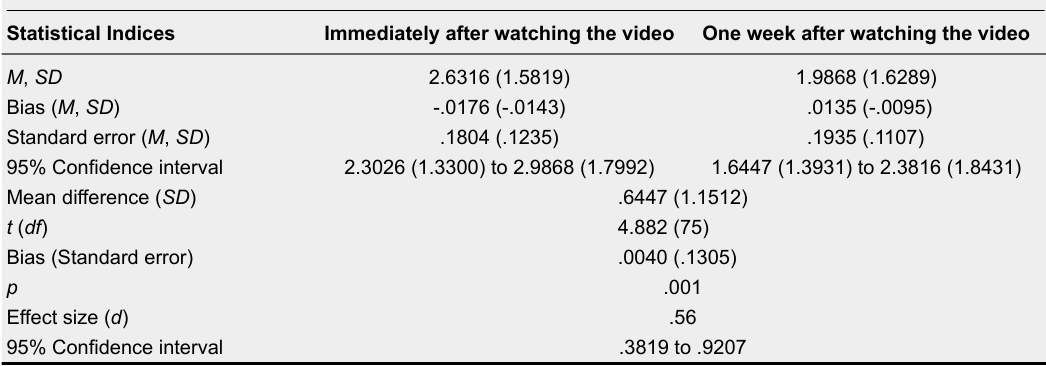
Results of the Paired T-Test Testing the Change in Opinions From Immediately After Watching the Video to One-Week After Watching the Video (Decay Effects Within One Week) Bootstrap paired t -test (based on 1000